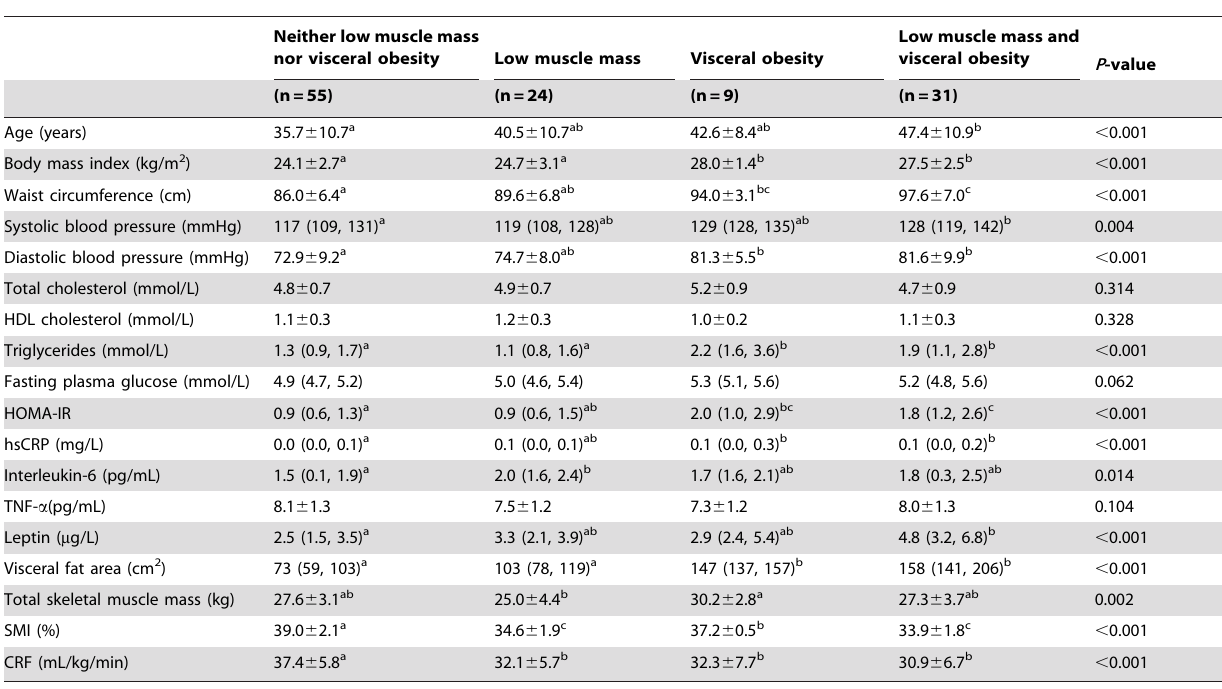
Table 2. Clinical, anthropometric, and metabolic characteristics of male study subjects.